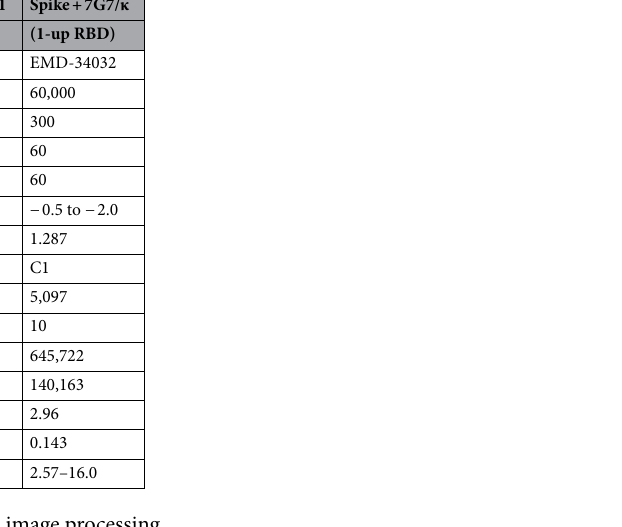
Table 3. Cryo-EM data collection and image